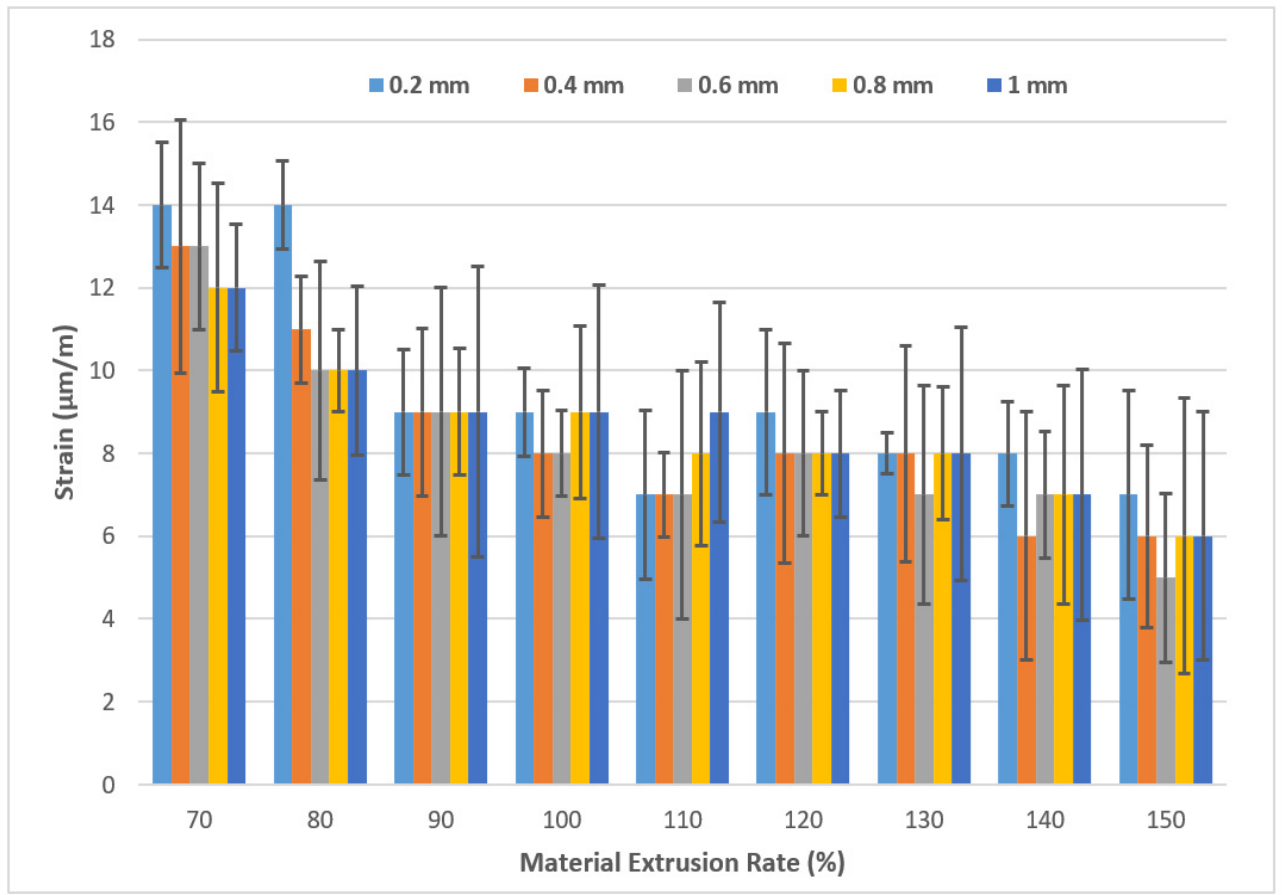
Figure 6. Results from strain